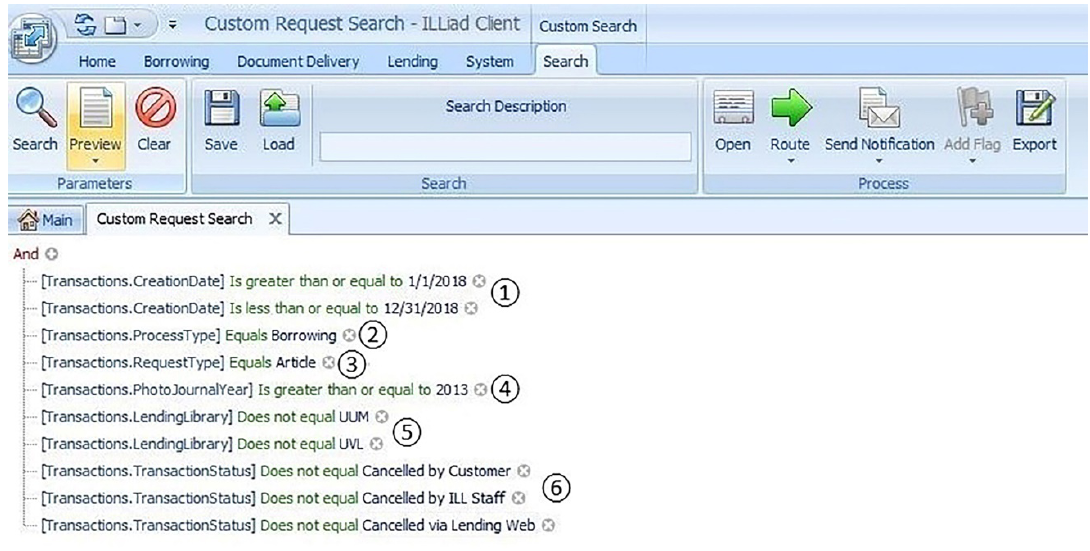
Figure 1 ILLiad search parameters for the custom